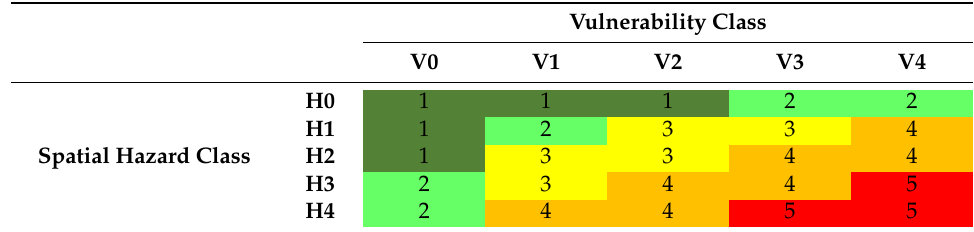
Table 5. Contingency matrix MATRIX 2 for deriving Specific Risk and Specific risk map over the study area. Cell numbers are associated to the Specific Risk class and then referred as R1-R5.